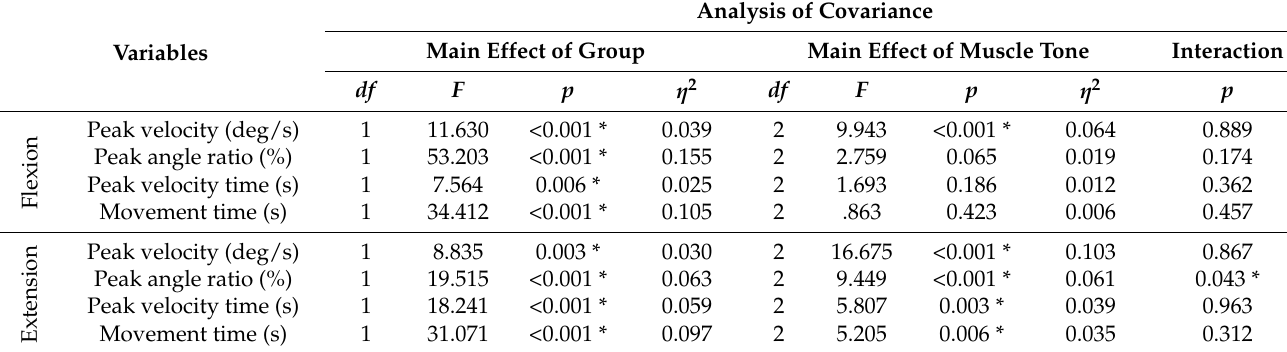
Table 3. Comparison of therapeutic techniques applied by students and therapists using a robot.